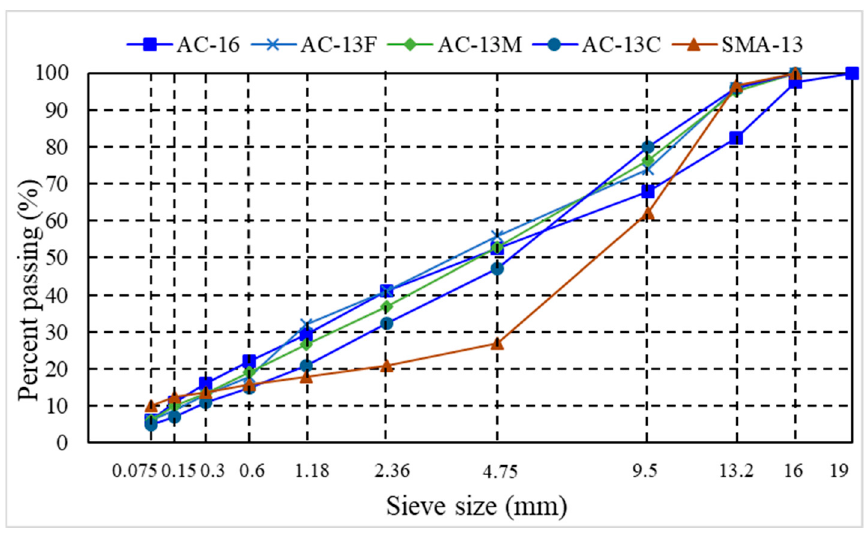
Figure 2. Gradations.